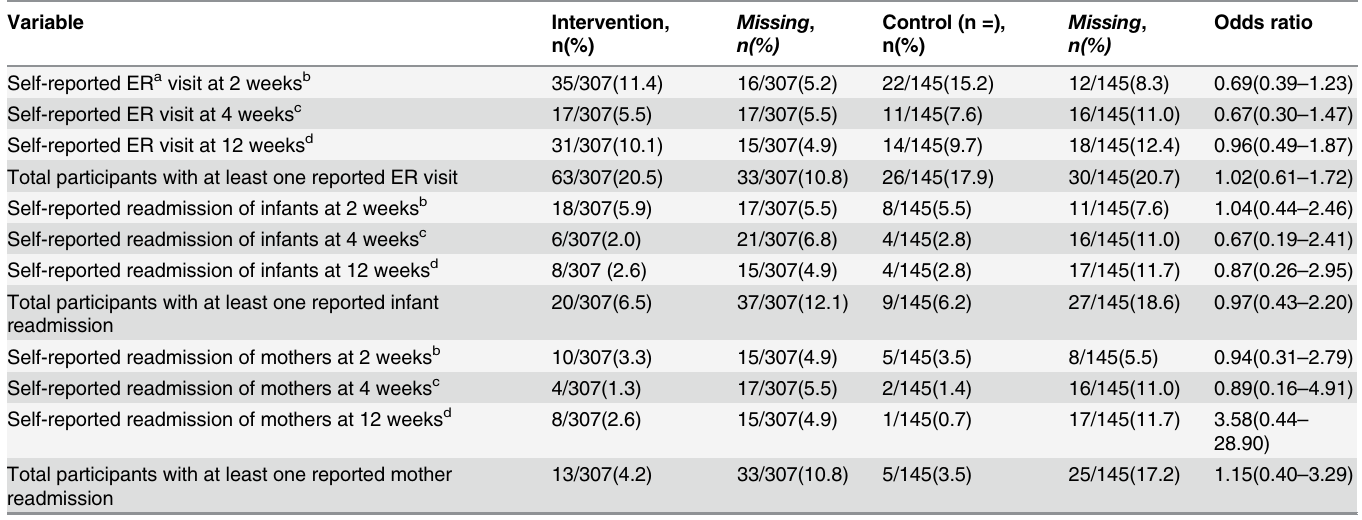
Table 6. Secondary outcome for use of healthcare